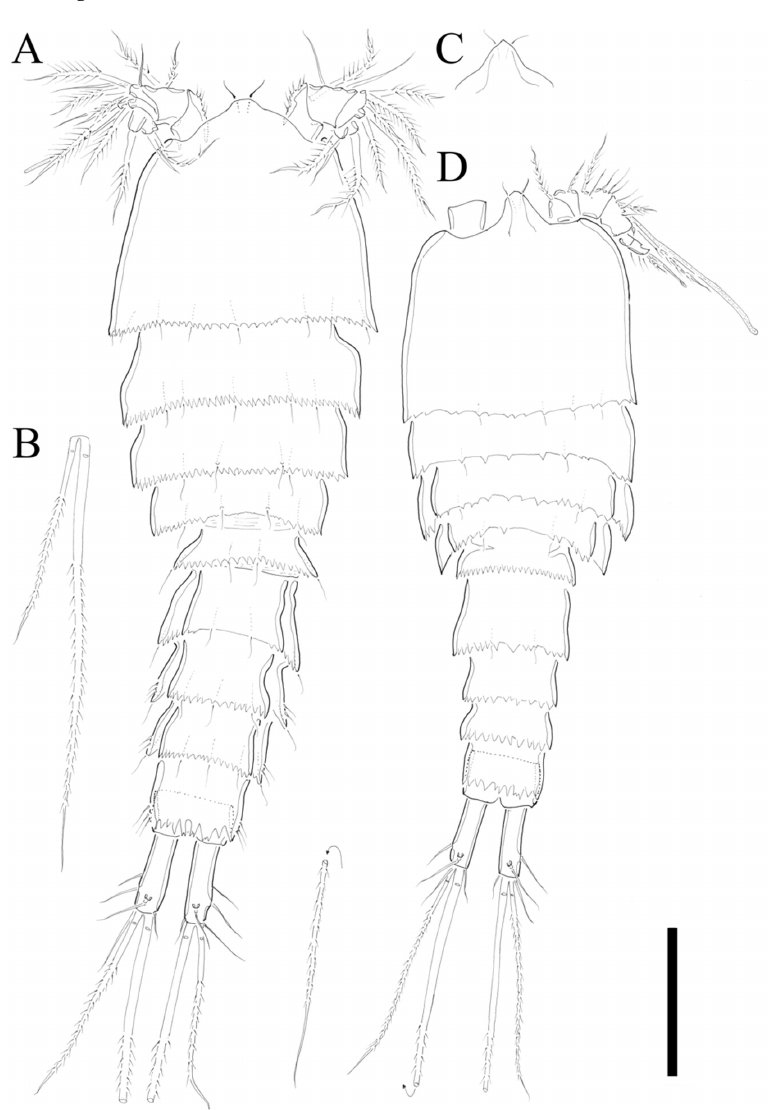
Figure 2. Zosime montagnai sp. nov. Female. ( A ) Habitus, dorsal; ( B ) Causal seta VI and V; ( C ) rostrum at different angle. Male. ( D ) Habitus, dorsal. Scale bar: 100 µm. Differential Diagnosis . Rostrum triangular, slightly pointed apically. Each somite armed with serrated posterior margin. Antennule seven-segmented in both sexes. Genital somite and succeeding urosomal segments with lateral expansions in the female. P3- and P4-bearing somites with lateral expansion on the male. Caudal rami three times longer than wide in both sexes. Female P5 with six setae, without seta on exp surface. Male P2